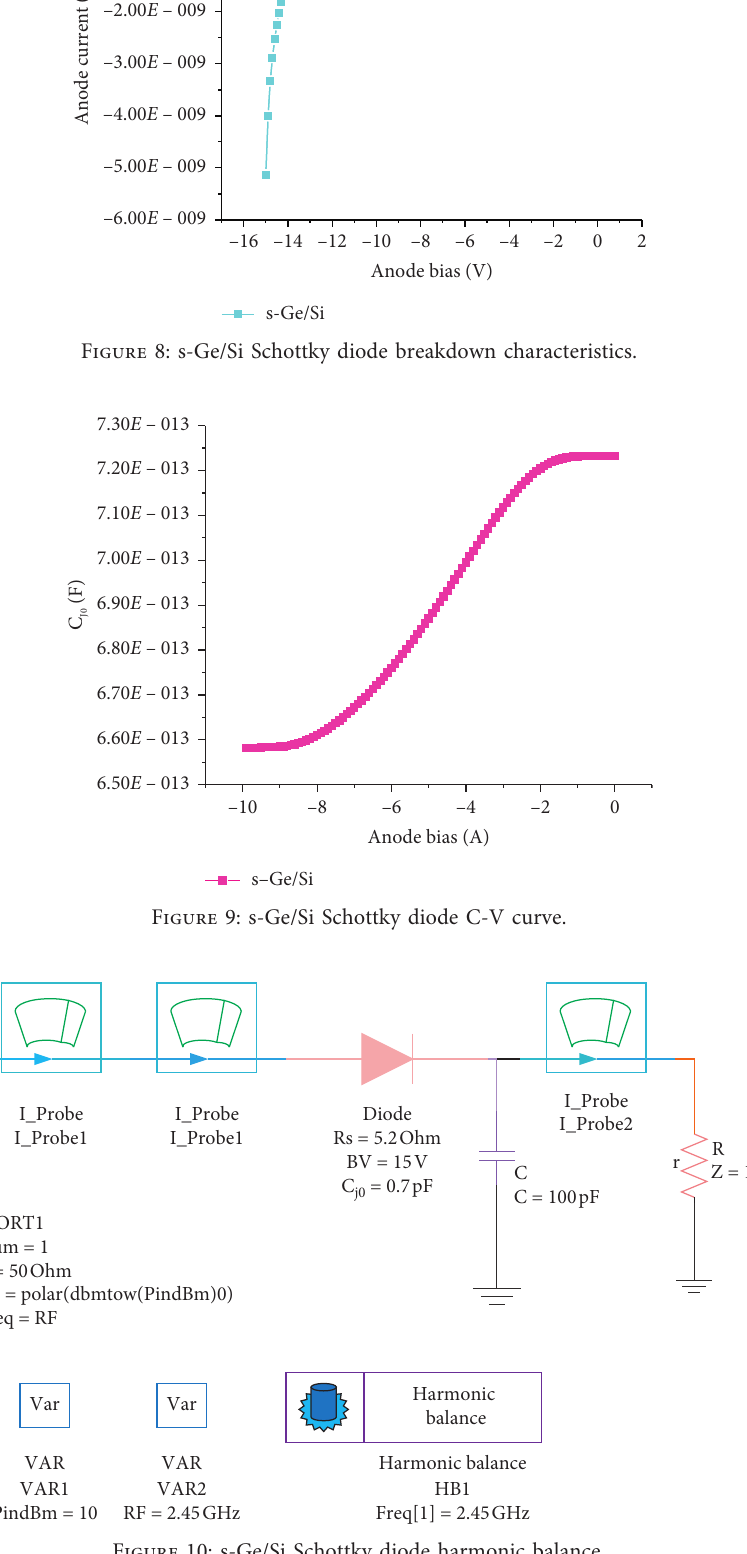
Figure 10: s-Ge/Si Schottky diode harmonic